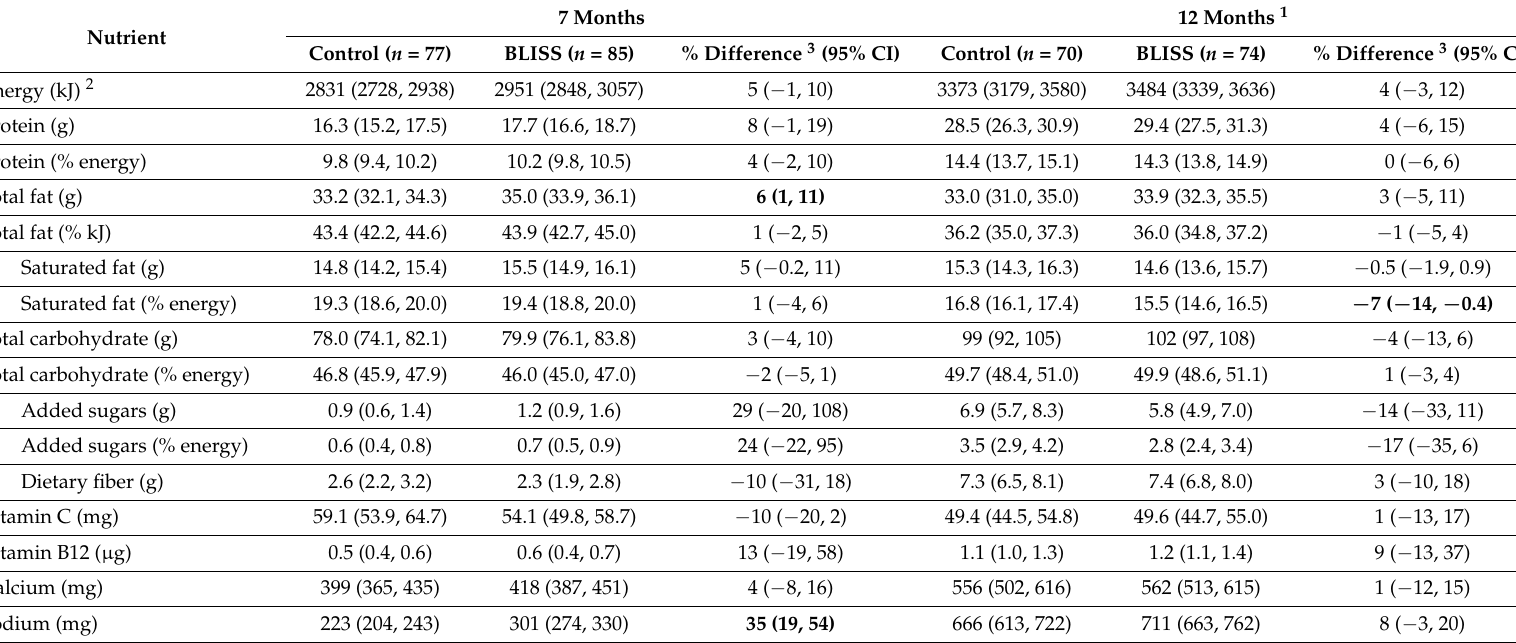
7 Months 12 Months